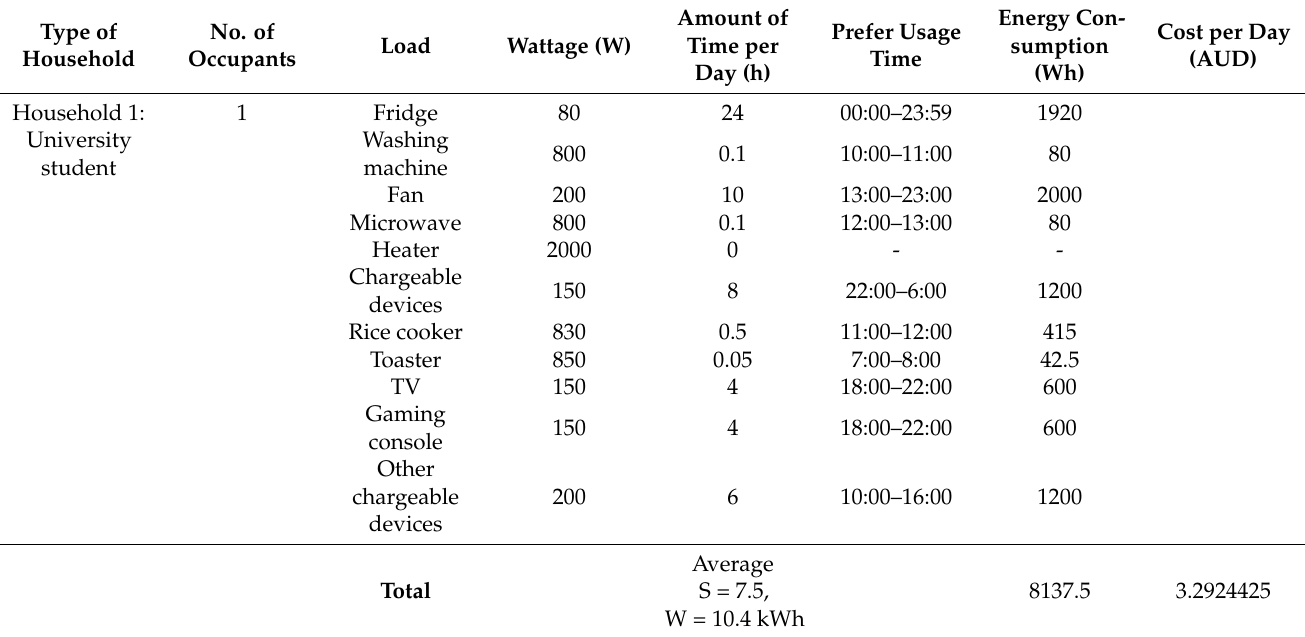
Table 3. Initial load profile 1 created for the project (summer).